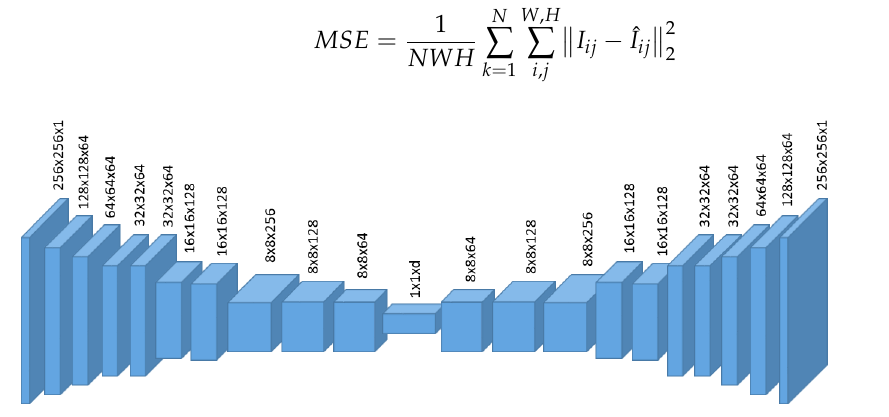
Figure 3. Details of encoder in our autoencoder architecture.